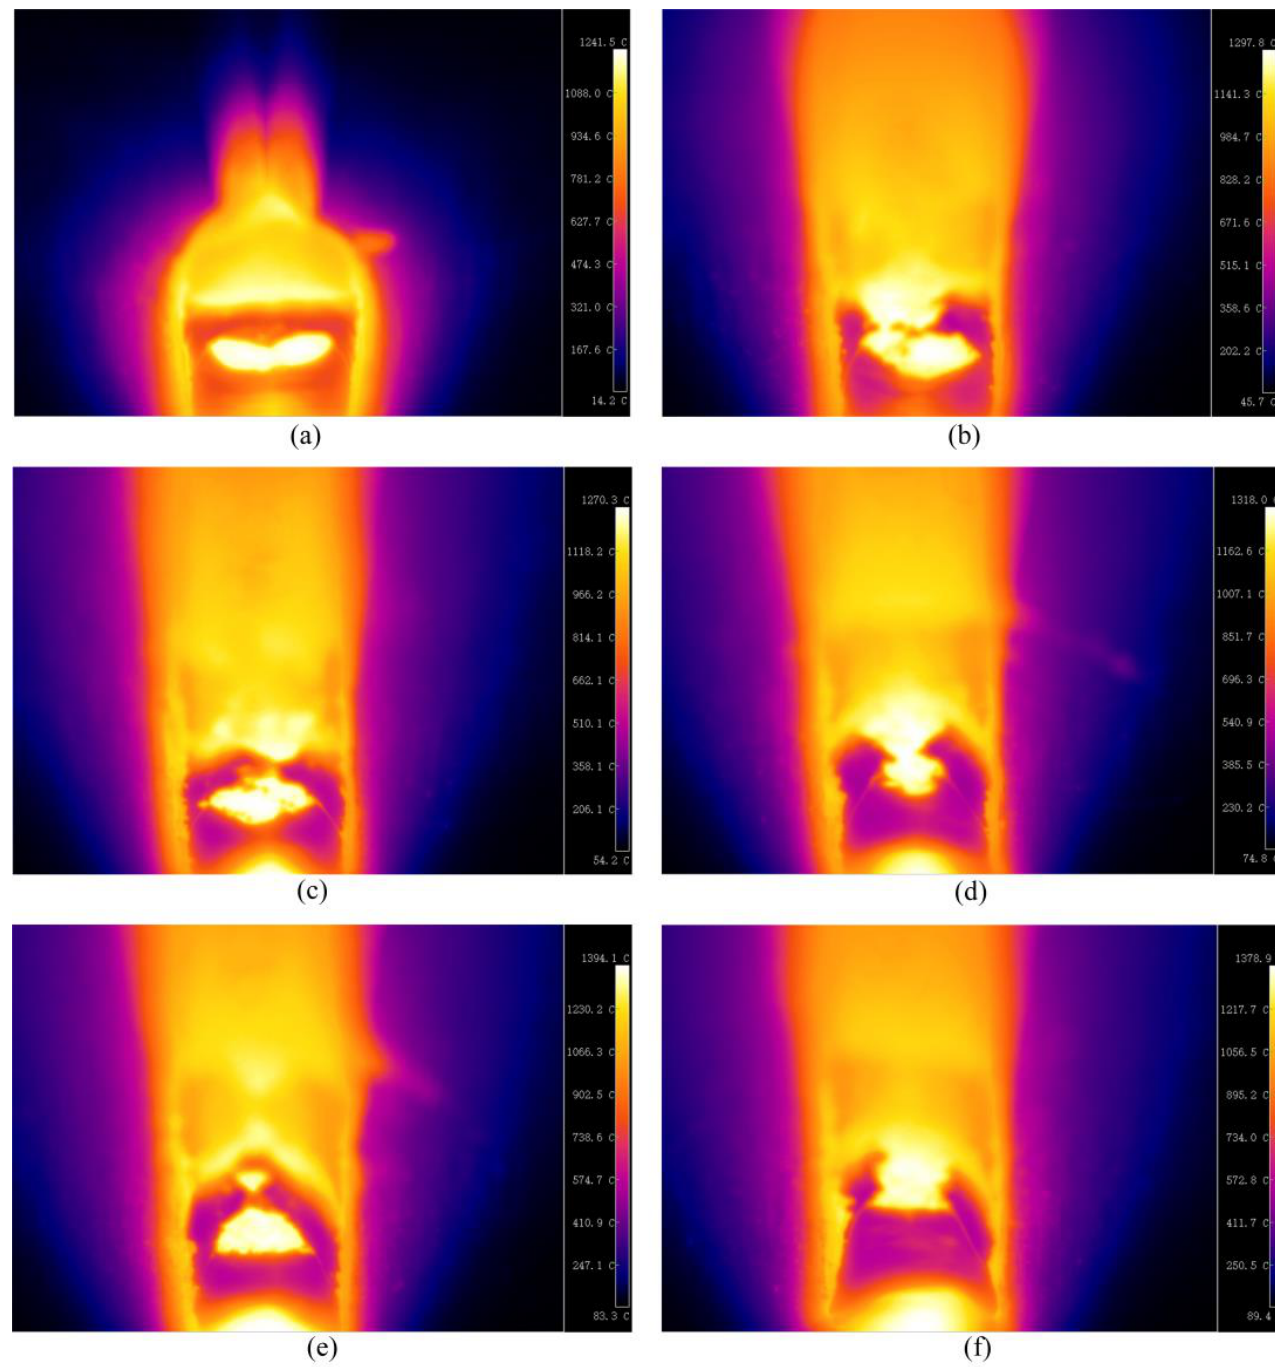
Figure 4. Temperature field images of a weldment surface measured at different times: ( a ) t = 4 s; ( b ) t = 8 s; ( c ) t = 12 s; ( d ) t = 20 s; ( e ) t = 25 s; ( f ) t = 29 s.